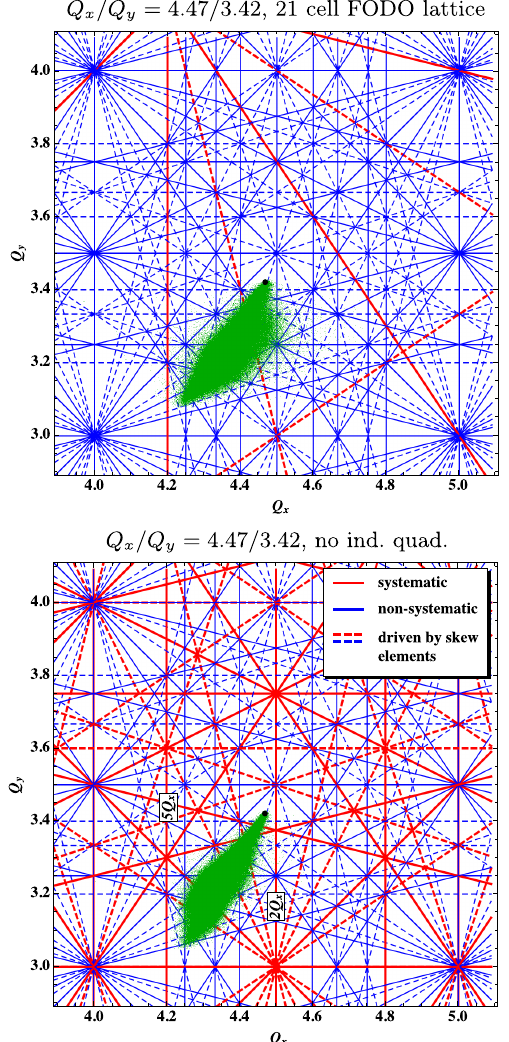
FIG. 23. Resonance diagram up to 5th order and tune footprint obtained with PTC-ORBIT of the initial distribution for the regular 21-cell FODO lattice (left) and the 21-cell FODO lattice with 3 × 2 cells of straight sections, dispersion suppression by adjusting the phase advance to 2 × 2 π over the arc and only two quadrupole families. Both lattices are matched to the working point Q x =Q y ¼ 4 . 47 = 3 . 42 . The initial distribution has been matched in both cases, taking only the linear dispersion into